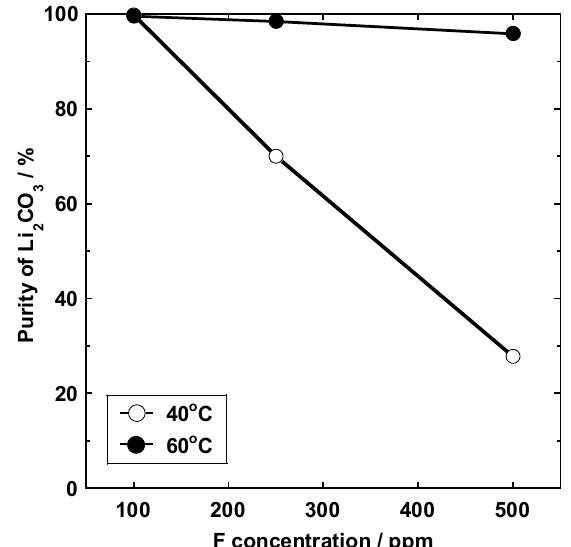
Figure 11. Li 2 CO 3 concentrations in the precipitates obtained from fluorine solutions at 40 and 60 ° C.